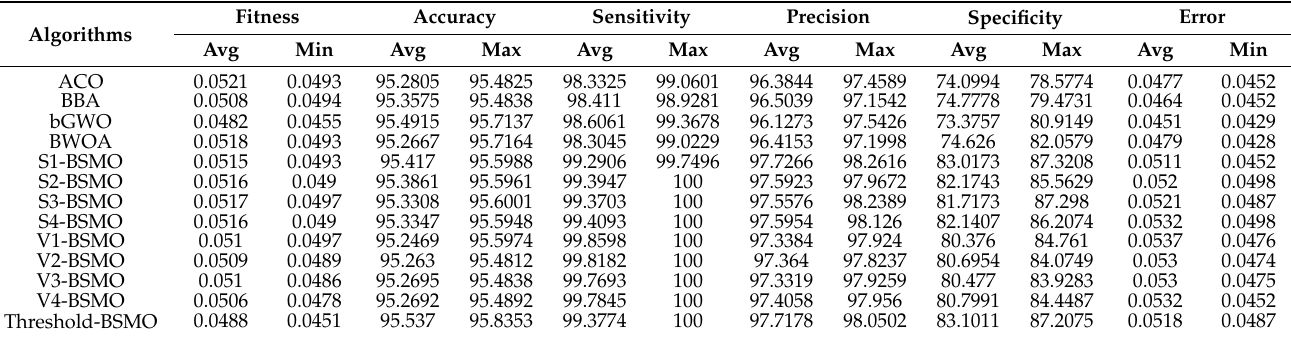
Table 6. Coronavirus disease 2019 (COVID-19)